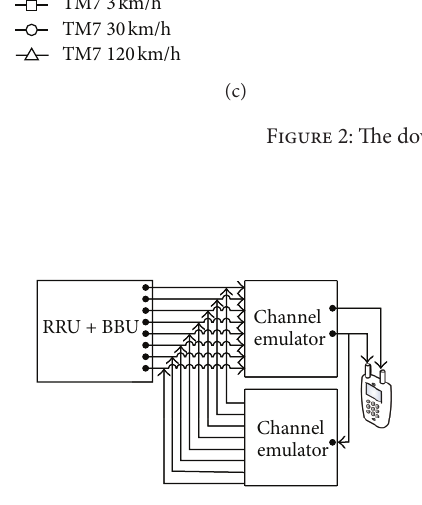
Figure 3: The indoor test